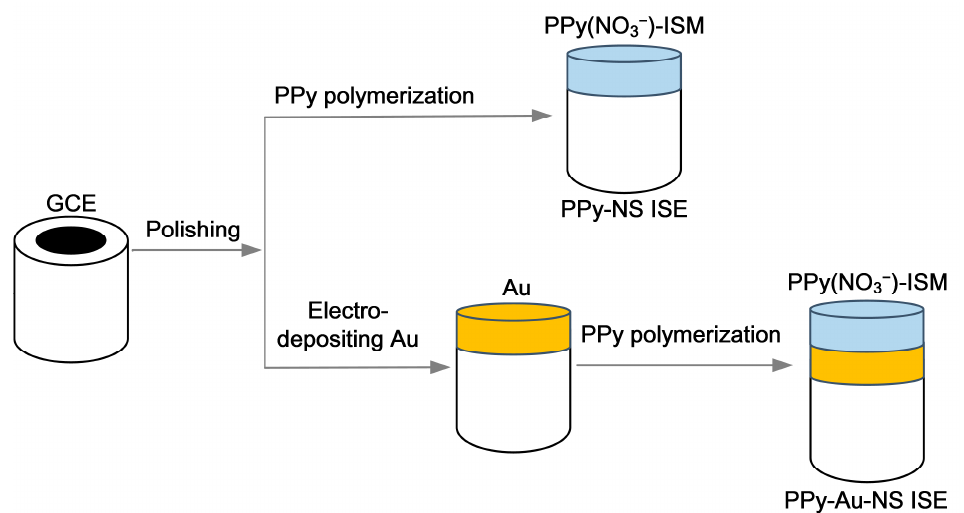
Figure 1. Synthesizing process for PPy-NS ISE and PPy-Au-NS ISE.